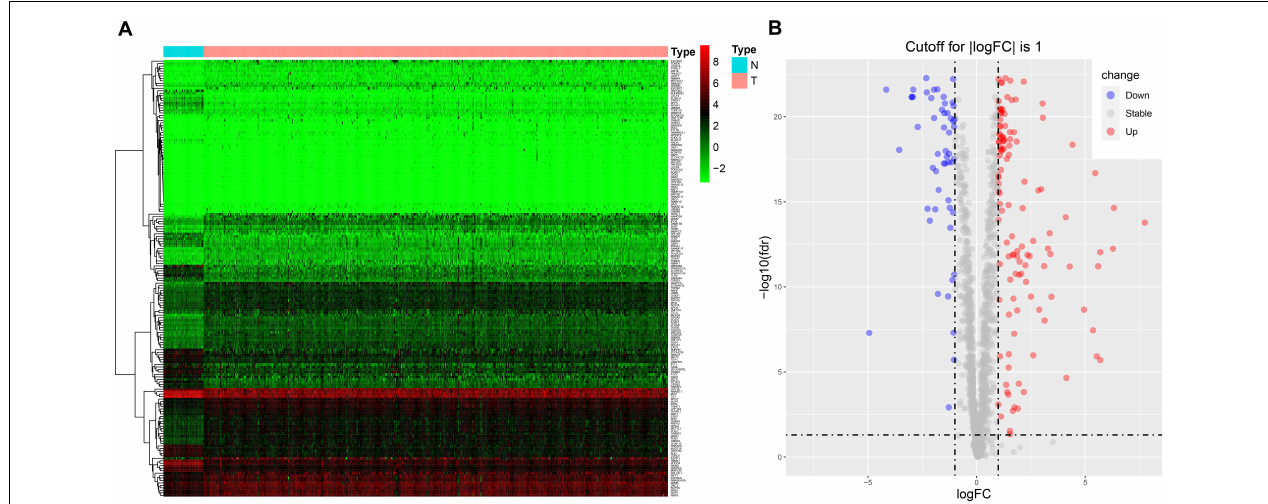
FIGURE 1 | The expression of DE RBPs in CRC based on data from TCGA. (A) Heatmap analysis of the differentially expressed RBPs between normal tissues and tumor tissues. Each column represents a tissue sample, and each row represents a differentially expressed RBP. Red indicates high expression, and green indicates low expression. N, normal; T, tumor. (B) Volcano plot of differentially expressed RBPs. The horizontal line is for adj p = 0.05, and the vertical lines are for | log 2 FC| =